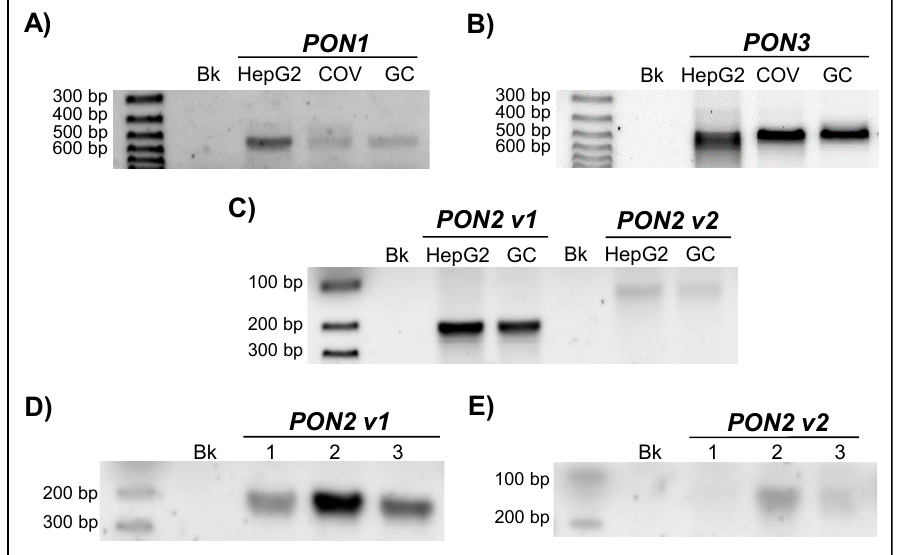
Figure 1. Detection of mRNA of ( A ) PON1, ( B ) PON3, and ( C – F ) PON2 variants (v1 and v2) in HepG2, COV434 (COV), and granulosa cells (GC). Bk, blank; 1–3, different samples of COV434. The PON2 gene is transcribed into different transcripts by alternative splicing [22].